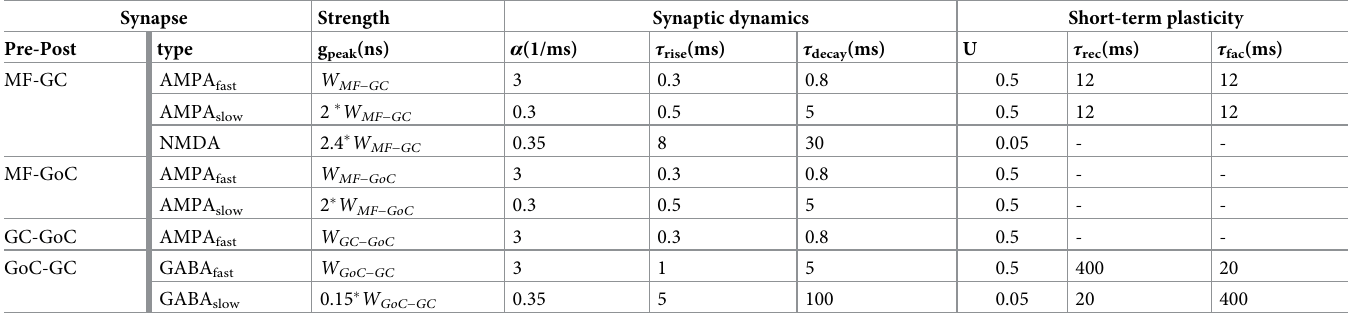
Table 2. The parameters of